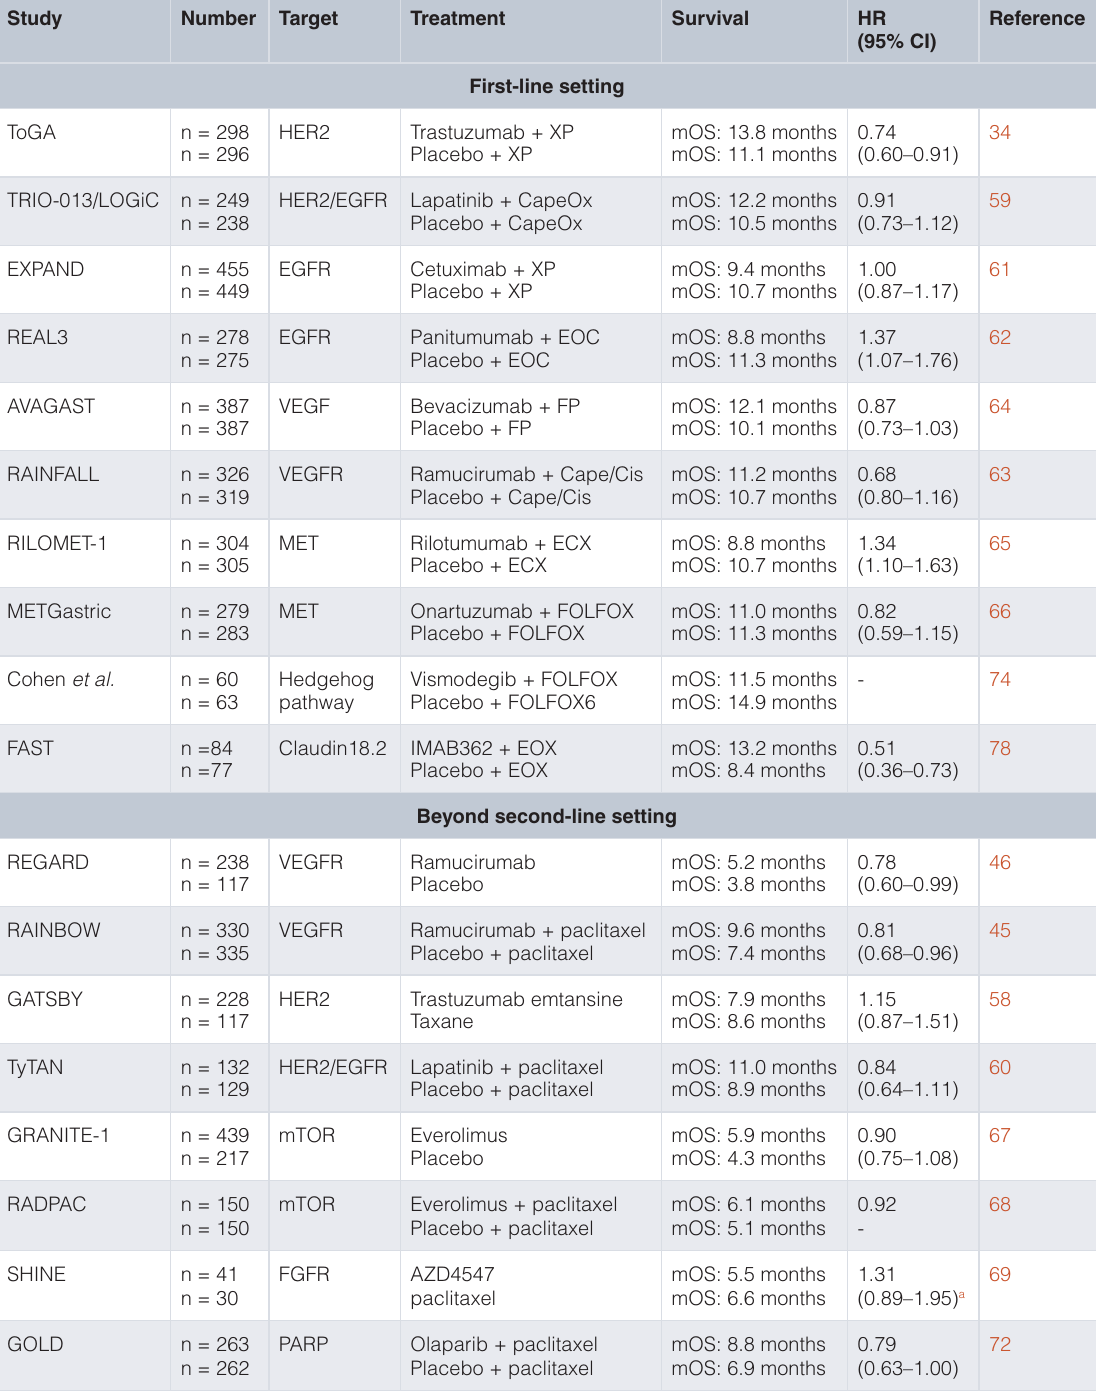
Table 2. Targeted therapy trial for metastatic gastric